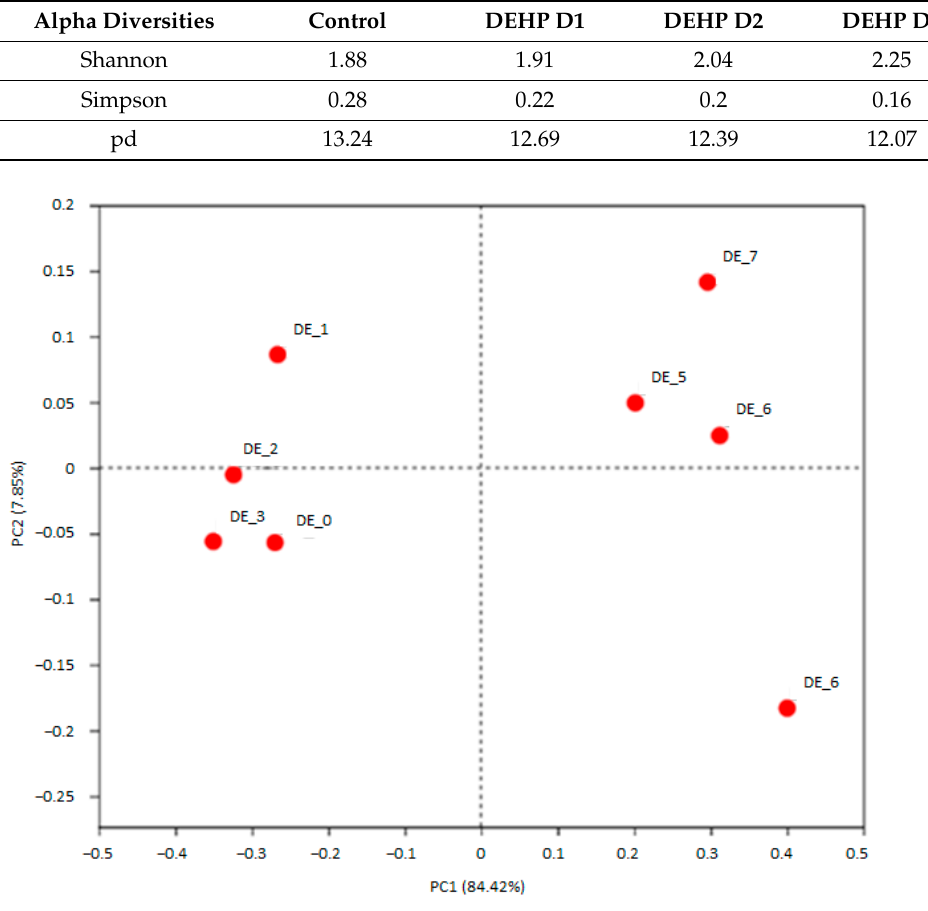
Figure 2. PCoA plot showing no DEHP control, DEHP-D1, DEHP-D2 and DEHP-D3 microbiota compositions at 0 h (DE_0 to DE_3) and 24 h (DE_4 to DE_7). The microbiota co-incubated with DINP-D1 and DINP-D2 showed fluctuated yet similar indices of Shannon, Simpson and pd compared with the control. At the highest dosage group (16.8 μ g/mL), the Shannon index was increased slightly while Simpson and pd remained stable (Table 2). DINP-D3 treated microbiota had higher feature diversity and richness, though they have similar phylogenetic distance. In the fermenters with DINP, starting microbiota compositions were clustered together. The taxonomy of no DINP control, DINP-D1 and DINP-D2 fermenters after 24 h incubation were clustered, while the DINP-D3 community shifted away from all the others in the PCoA plot (Figure 4). Microbial composition in the DINP-D3 fermenter was deviated from no DINP control, DINP-D1 and DINP-D2. Dose-dependent increases in the relative abundance of phyla Ac- tinobacteria, Cyanobacteria and Proteobacteria were detected (Figure 5A). At the Genus level, the relative abundance of Streptococcus and Lactococcus were increased in DINP-D1 and DINP-D3 fermenters, while they stayed relatively stable in DINP-D2. Moreover, the relative abundance of Blautia , Catenibacterium , Dorea , Escherichia-Shigella , Holdemanella and Prevotella_2 in the DINP-D3 fermenter were around two-fold that in the control fermenter. Though increases in Prevotella_2 were observed in the DINP-D3 community, the relative abundance of Prevotella_9 was reduced by about 40% compared with control. Finally, a dramatic shrink in Megasphaera abundance was detected in the DINP-D3 community (Fig- ure 3B).